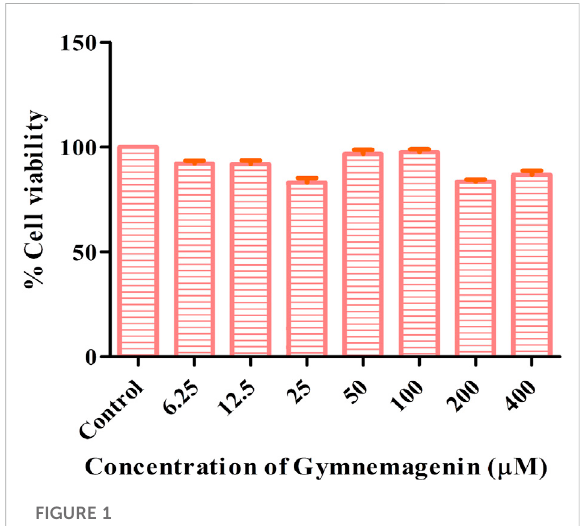
FIGURE 1 Determination of cytotoxic effects of gymnemagenin